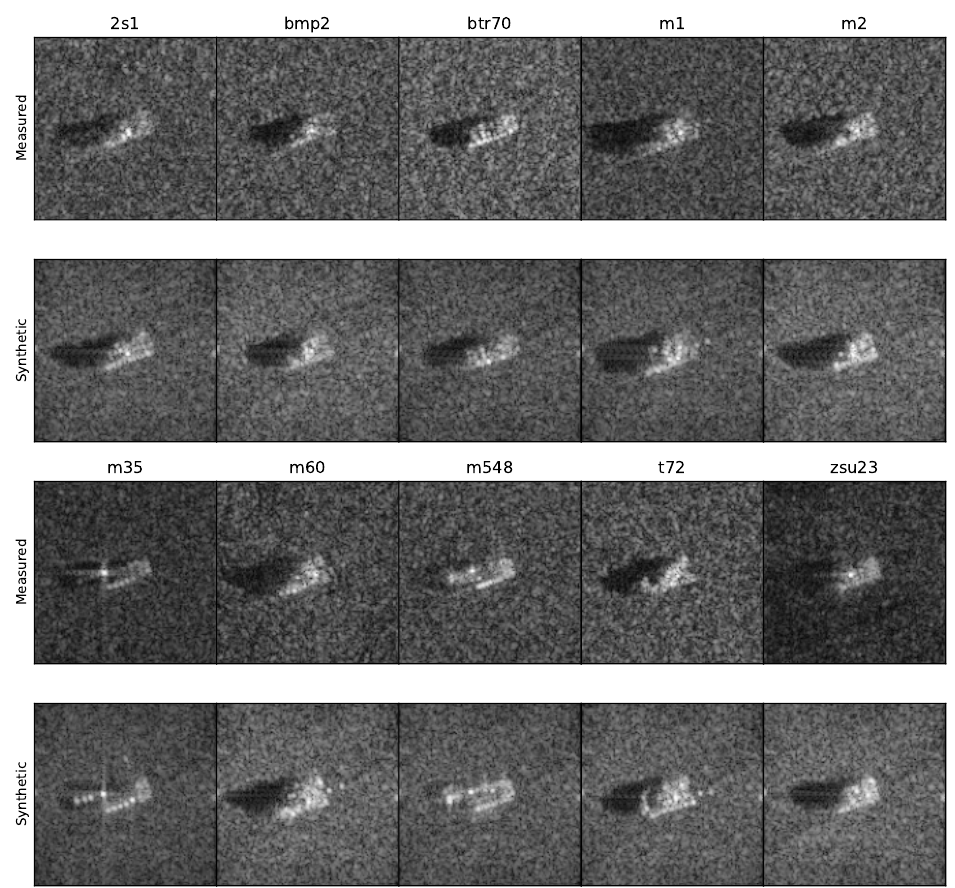
Figure 5. Example of one image of each vehicle in the SAMPLE dataset. Measured MSTAR images are on the top row, and the corresponding synthetic images are on the bottom row. The order of the vehicles from left to right is the same as presented in Table 1. We see that details such as shadows, orientation, and relative return magnitudes are in good agreement [38,44]